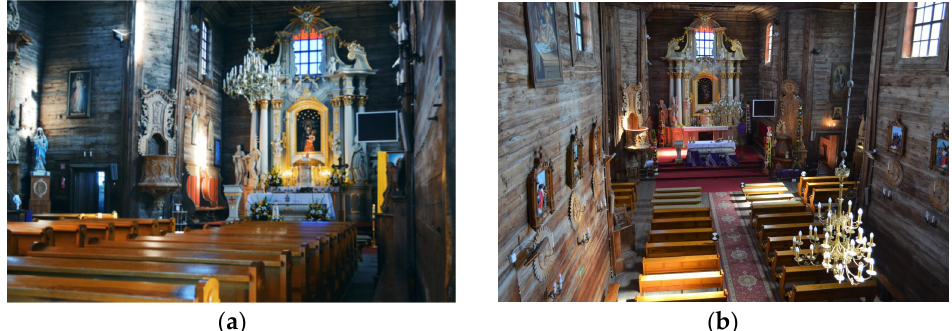
Figure 3 . Interior of the church of St. Szczepan in Mnichów: view from the altar ( a ) and view from the choir on the altar ( b ); (source: private archive)